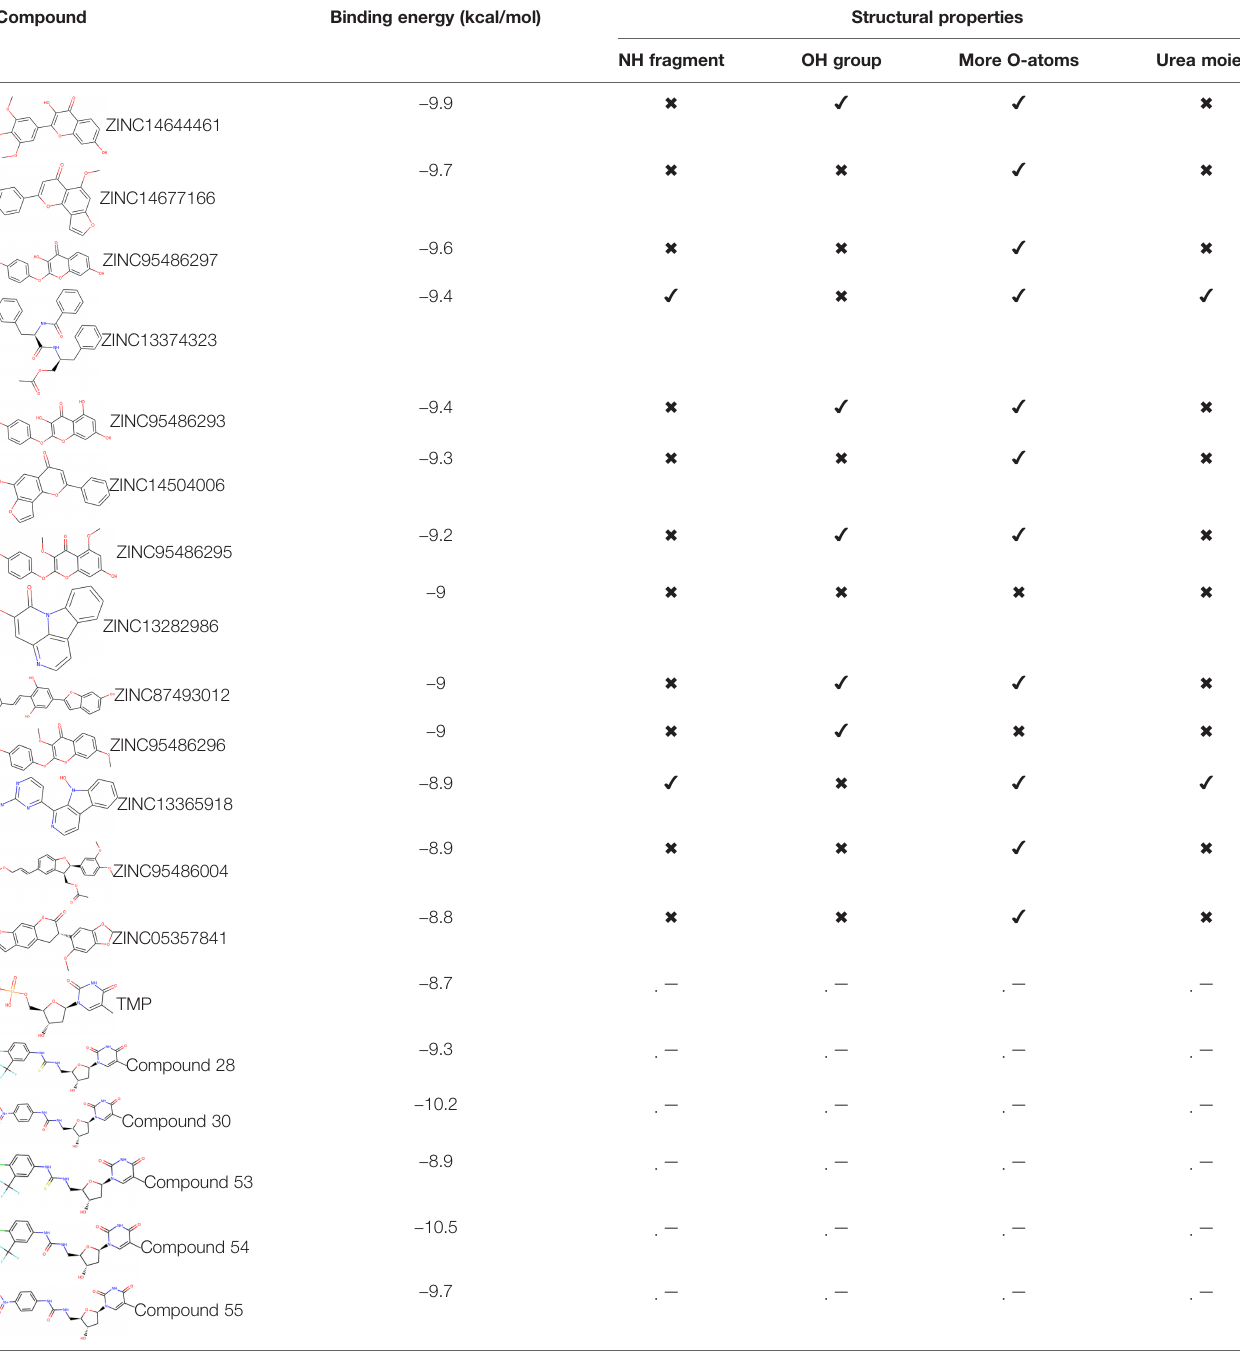
TABLE 2 | List of hits showing their structures, binding energies, and structural